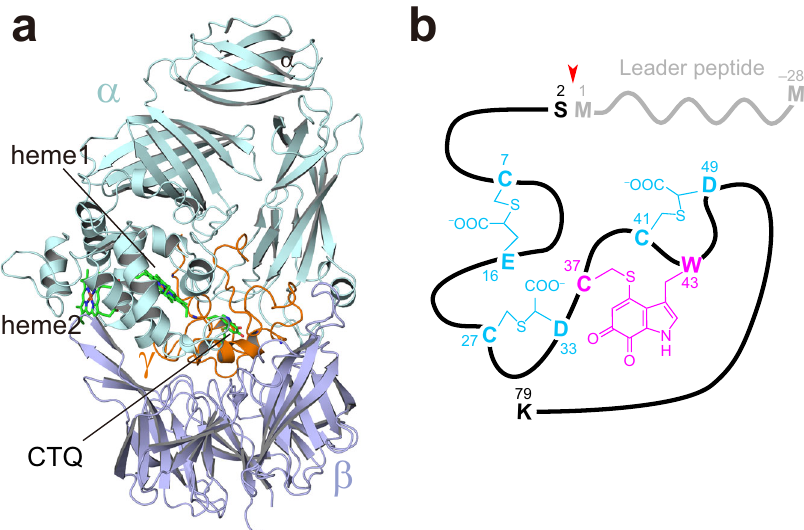
Fig. 1 Crystal structure of QHNDH and schematic representation of γ -subunit. a Overall structure of QHNDH from Ps. putida . The α -subunit (QhpA, pale cyan), β -subunit (QhpB, purple), and γ -subunit (QhpC, orange) are depicted by a cartoon model with two hemes and CTQ shown in green stick model. b Schematic presentation of γ -subunit polypeptide with a 28-residue leader peptide (light gray). Chemical structures of thioether crosslinks and CTQ are shown in cyan and magenta, respectively. The QhpE-cleavage site is indicated by a red